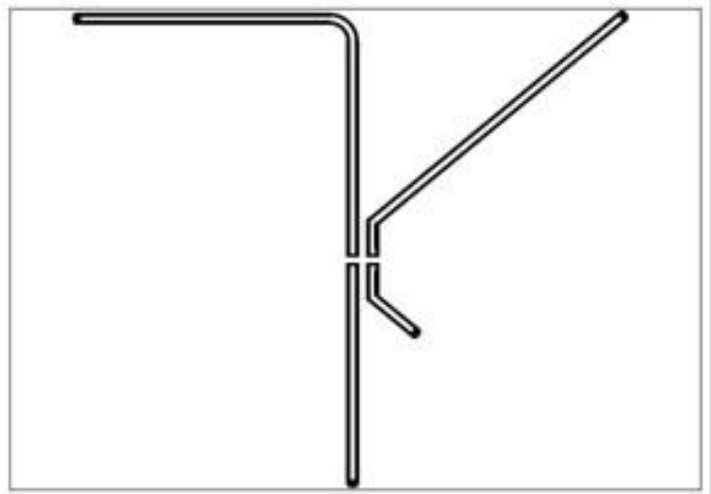
Fig. 4. Layout for printing microstrip phase shift lines feeding the antenna.